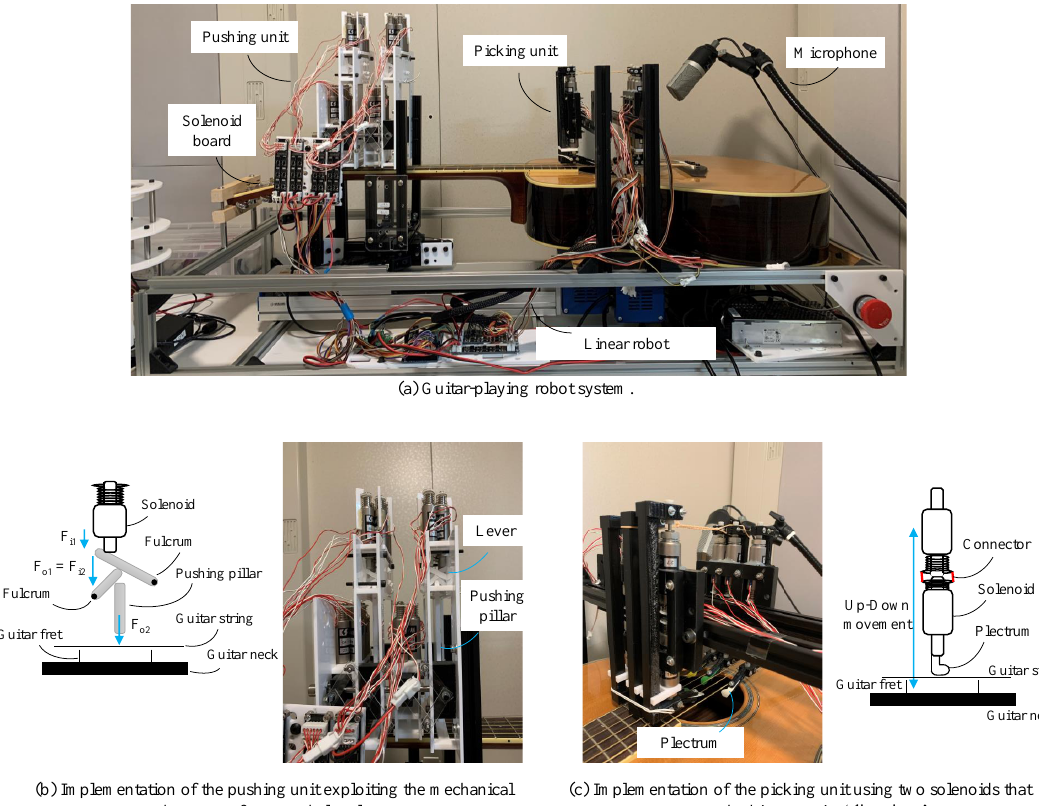
Figure 2. The developed guitar-playing robot system. The robot system consists of a single-axis robot, string-pushing unit, picking unit, and an actual guitar. ( a ) The guitar-playing robot system. The microphone is placed near the guitar sound hole. ( b ) Implementation of the pushing